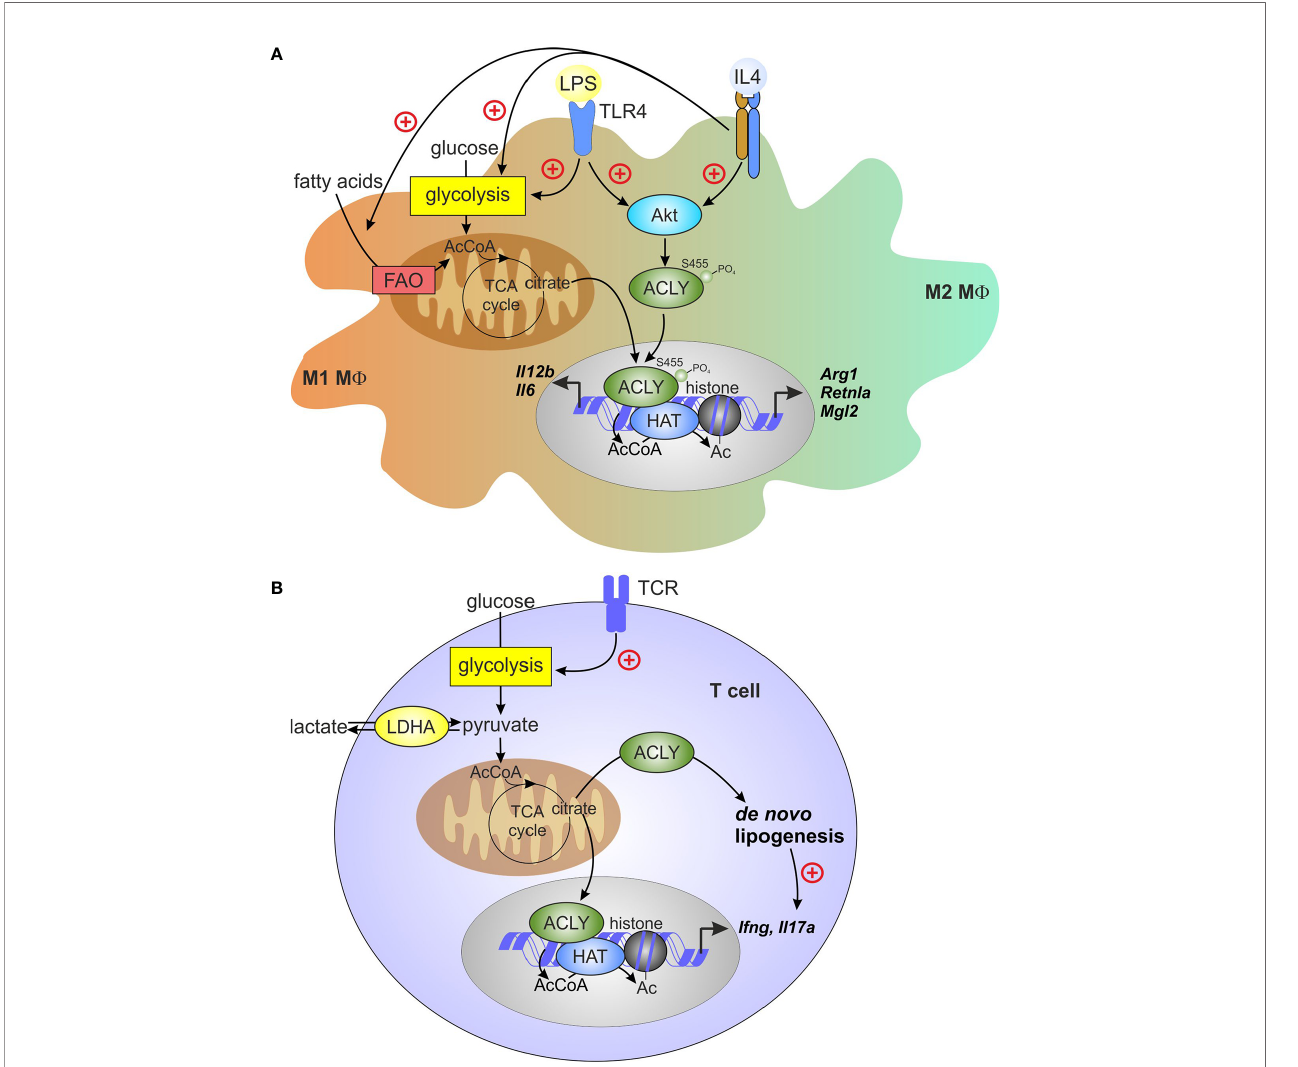
FIGURE 2 | ACLY in macrophages and T cells. (A) Macrophage pro-in fl ammatory (M1) activation by toll-like receptor 4 (TLR4) ligand lipopolysaccharide (LPS) or alternative (M2) activation by interleukin (IL)-4 induces Akt-dependent phosphorylation and activation of ACLY. TLR4 activation enhances glycolysis and, in the early phase of in fl ammatory response, increases TCA cycle fl ux to citrate. citrate translocates to cytosol and the nucleus for ACLY-dependent acetyl-CoA (AcCoA) formation. In IL-4-stimulated cells, both fatty acid oxidation (FAO) and glycolysis contribute to AcCoA generation. ACLY-dependent AcCoA provides substrate for histone acetylation, which supports increased expression of pro-in fl ammatory genes ( il6, il12b ) or IL-4 target genes ( Arg1, Retnla, Mgl2 ). (B) T-cell receptor ligation during activation of effector T cells increases glycolysis, thereby enhancing pyruvate to lactate conversion by lactate dehydrogenase (LDH). This conversion promotes citrate exit from the TCA cycle, driving cytosolic AcCoA generation by ACLY. Under in fl ammatory conditions, extracellular lactate may enter T cells and feed to TCA cycle, providing a source of citrate. ACLY-derived AcCoA supports de novo lipogenesis in activated T cells, and provides substrate for histone acetylation, which is necessary for increased expression of ifng . De novo lipogenesis promotes il17a expression in activated T H 17